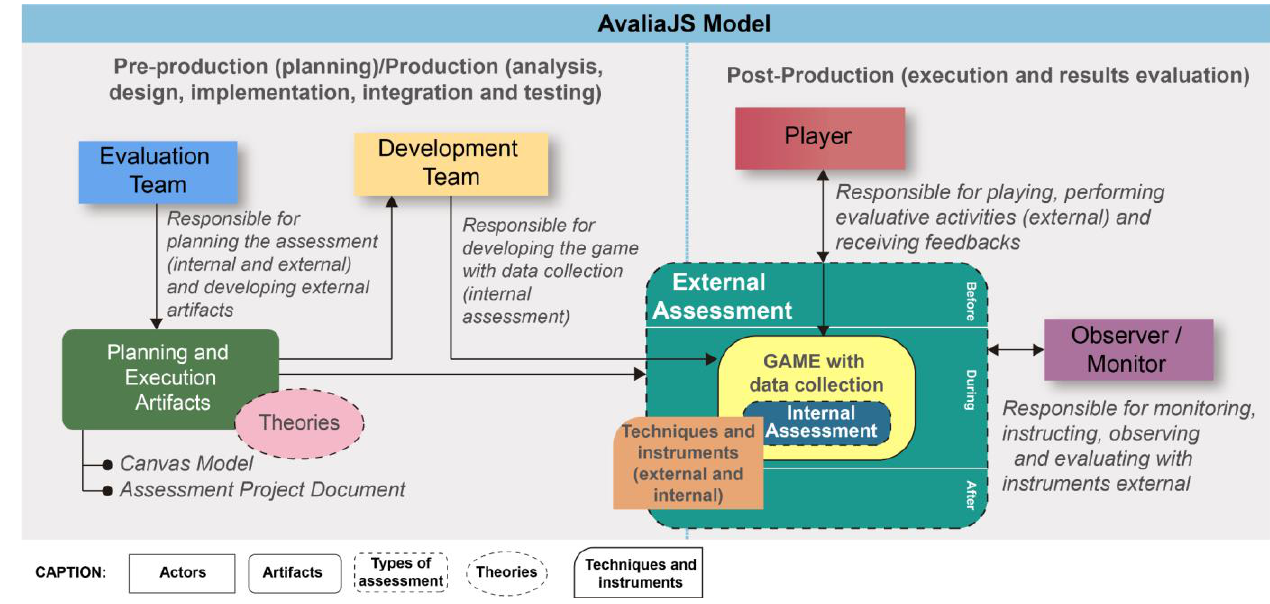
Figure 1. AvaliaJS overview: a conceptual model for planning of the design and execution of student performance assessment in SGs.